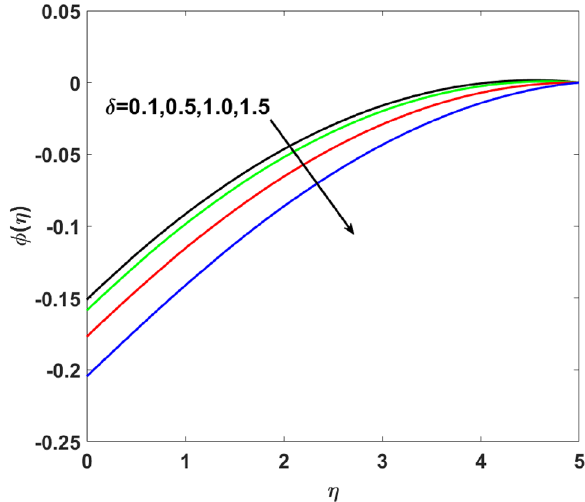
Figure 16. φ(η) versus δ .